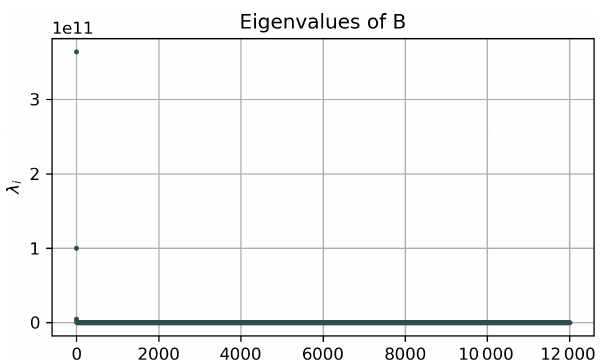
Figure B1. Spectrum of the classical MDS kernel matrix B for the Agulhas flow, where we first constrain the particle data to 12000 randomly selected trajectories. There are again two dominant eigen- values for which we choose the corresponding vectors for embed- ding in Sect. 4.2.